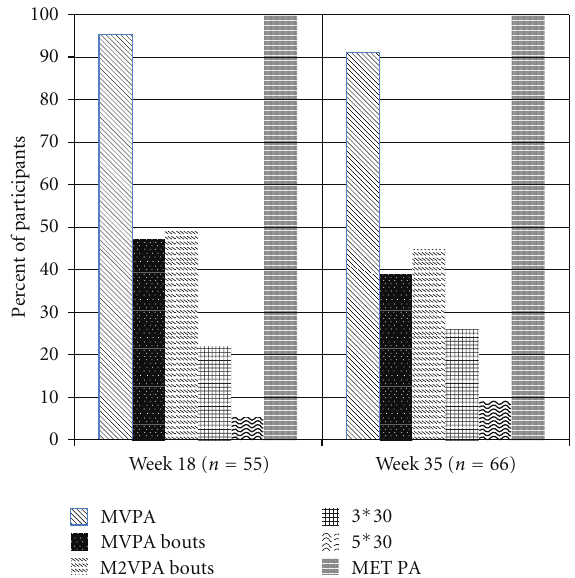
F 1: Percentage of pregnant women meeting physical